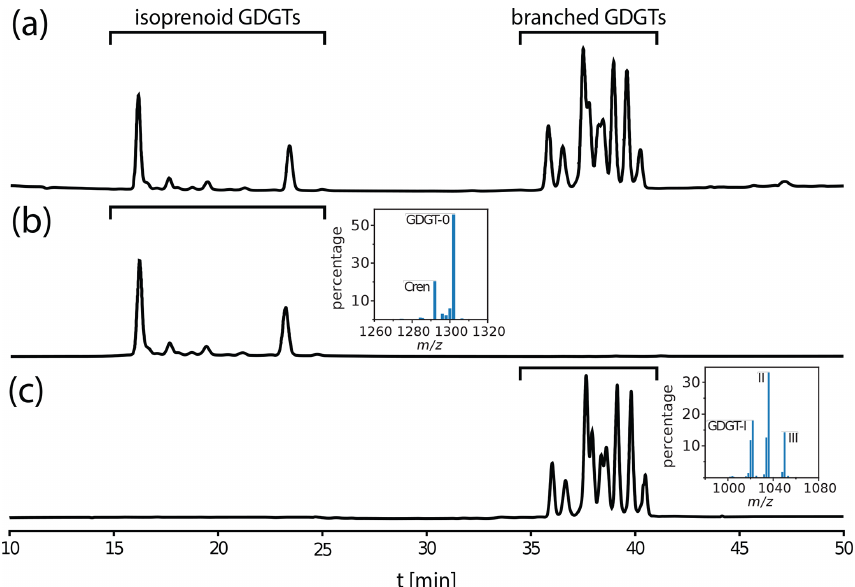
Figure 1. High-performance liquid chromatography (HPLC) mass chromatograms ( m/z 500–1500) of glycerol dialkyl glycerol tetraethers (GDGTs) from a composition topsoil sample. (a) Sample before GDGT isolation. (b) The separated isoprenoid fraction and its composite mass spectrum (GDGT-3, GDGT-2 and GDGT-1, from left to right, between Crenarchaeol (Cren) and GDGT-0, which are not labeled). (c) The separated branched fraction and its composite mass spectrum (GDGT-I, II and III corresponding to tetra-, penta- and hexamethylated GDGTs, which are labeled). For molecular structures, see Fig. A1.